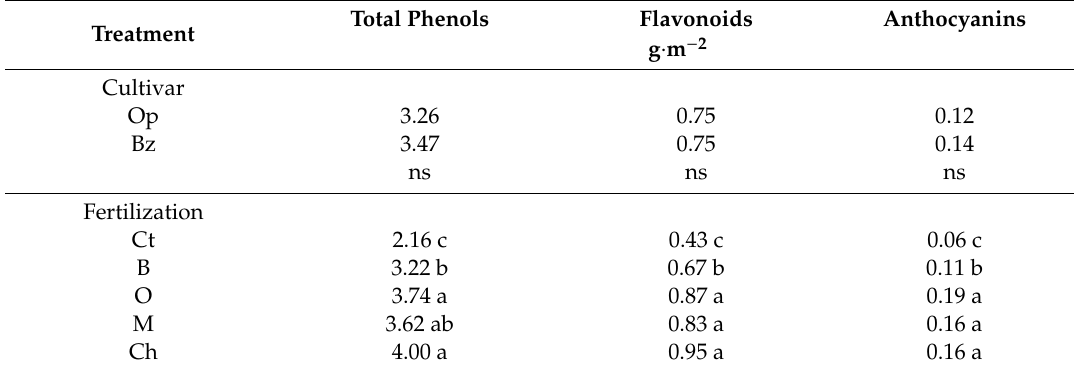
Table 4. Antioxidant compounds in basil dry leaves per soil surface unit, as a ff ected by cultivar and